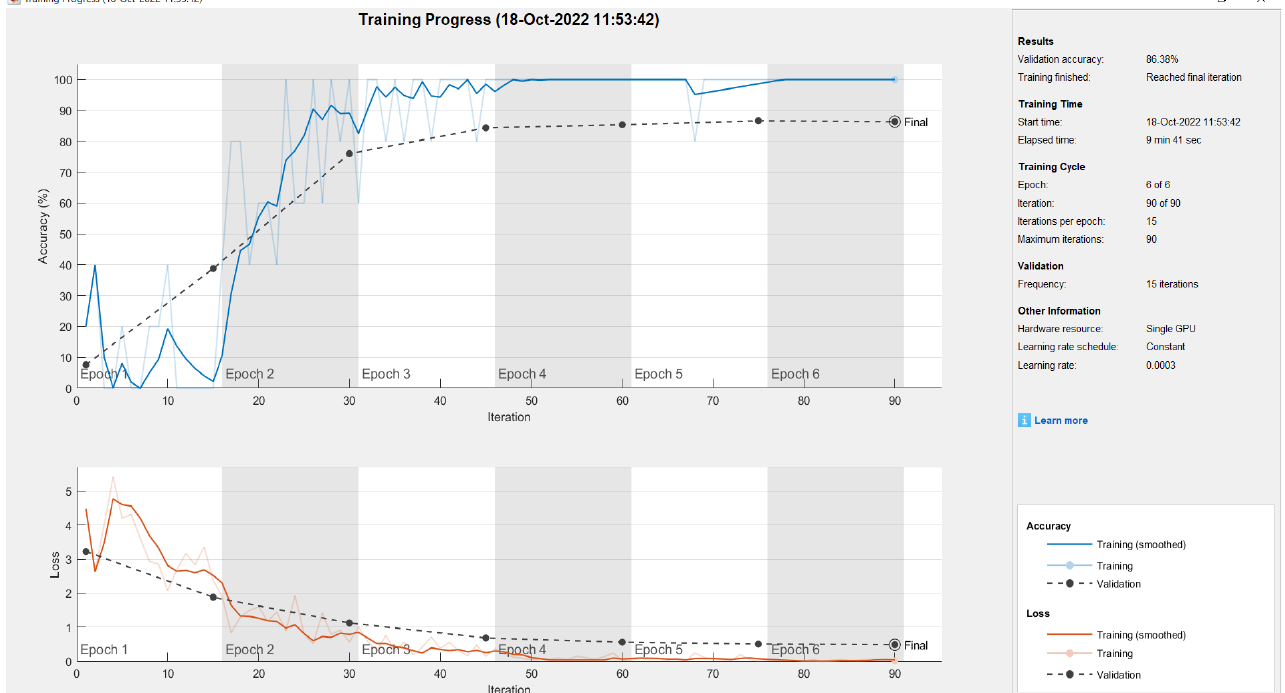
Figure 16. Result of training progress trash object using GoogleNet.